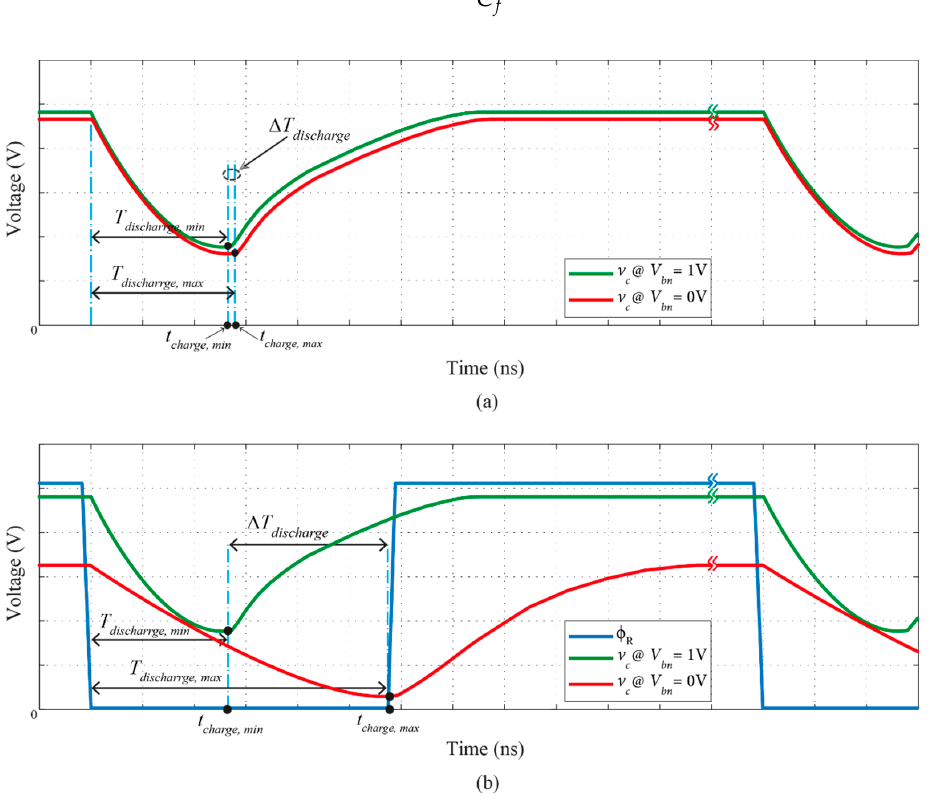
Figure 3. Difference in discharge rates for two cases: ( a ) without CRC; and ( b ) with CRC.